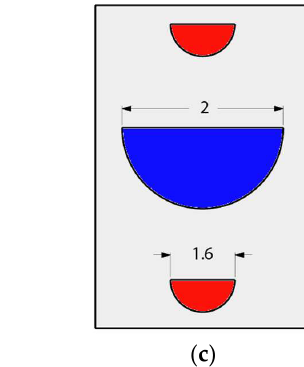
Figure 24. Total cost of PCHE vs. Reynolds number.